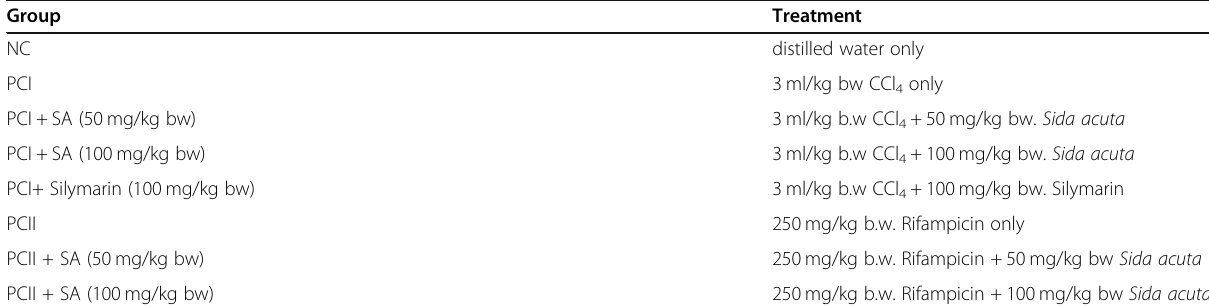
Table 1 Animal grouping and treatments Group Treatment NC